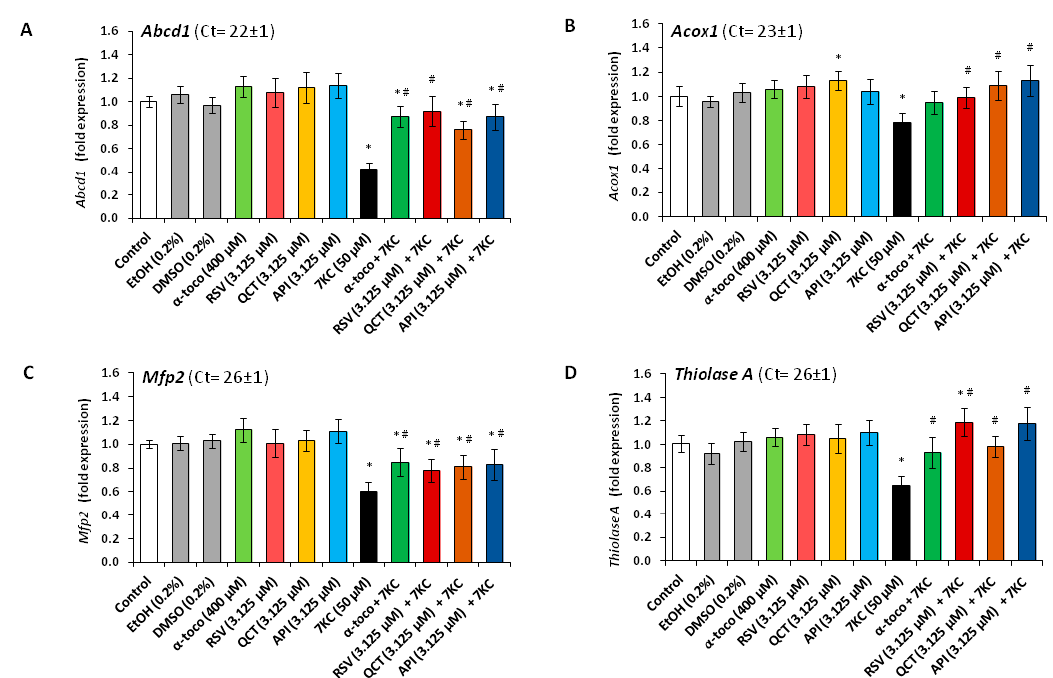
Figure 10. Effect of resveratrol, quercetin, apigenin and α -tocopherol on 7KC-induced changes of peroxisomal β -oxidation: measurement of the mRNA levels of Abcd1 , Acox1 , Mfp2 and Thiolase A